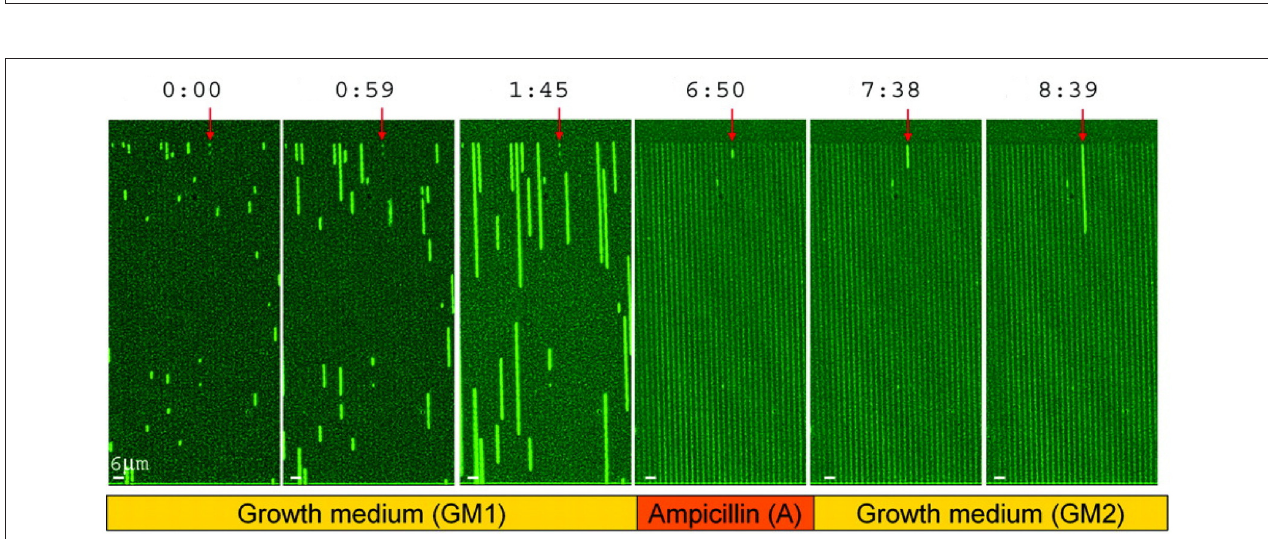
FIGURE 8 | Heterogeneity in urea uptake by P. minimum at the single-cell level. (A) P. minimum cells in UV light. (B) 15 N-urea uptake by P. minimum cells depicted as 12 C 15 N − / 12 C 14 N − ratio. Scale bar is 5 µ m. Reproduced from Matantseva et al. (2016) with permission.